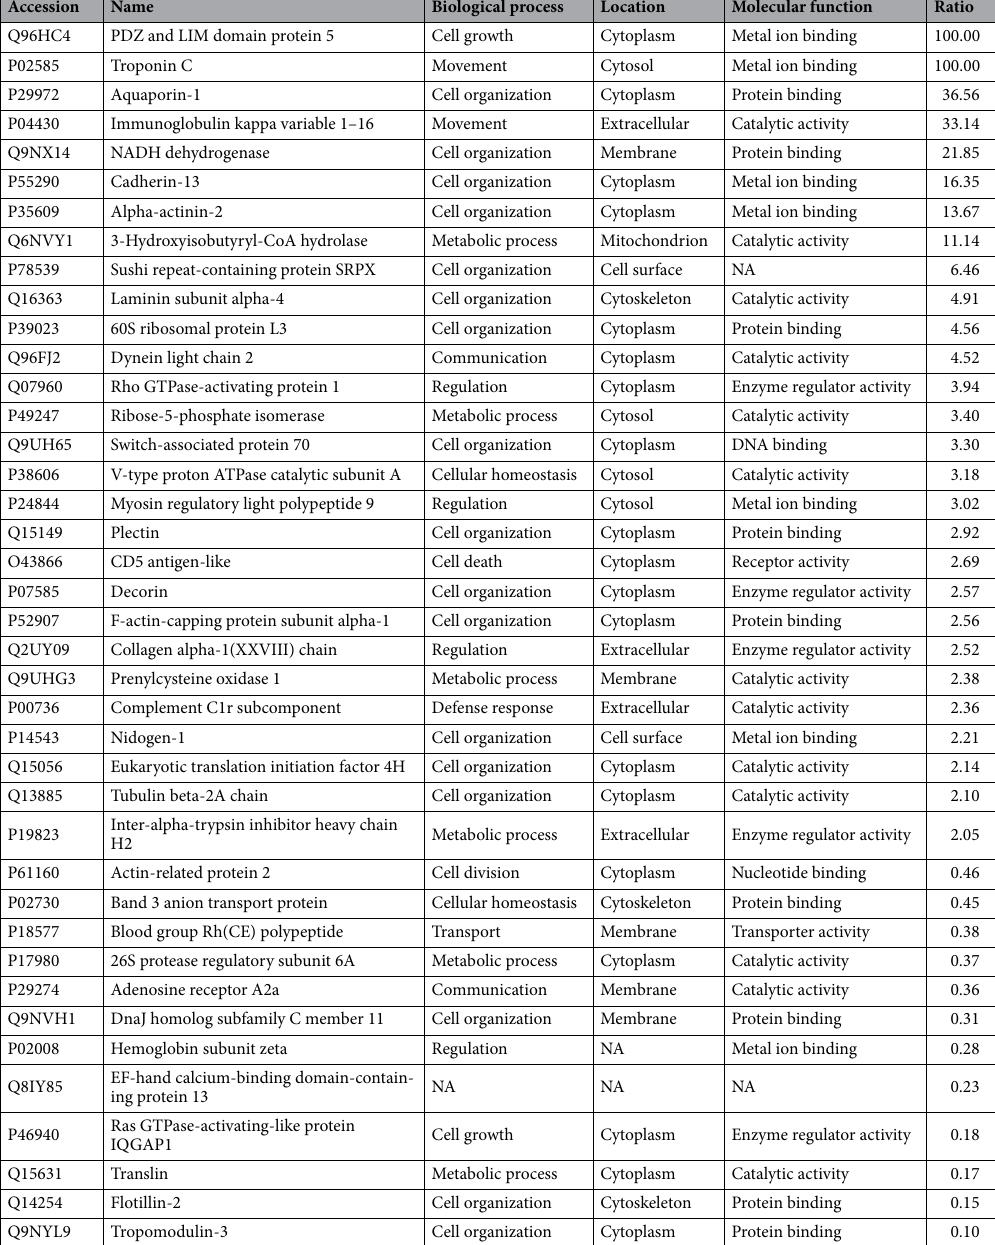
Table 3. Changed proteins of extraocular muscle in craniosynostosis versus control. NA no